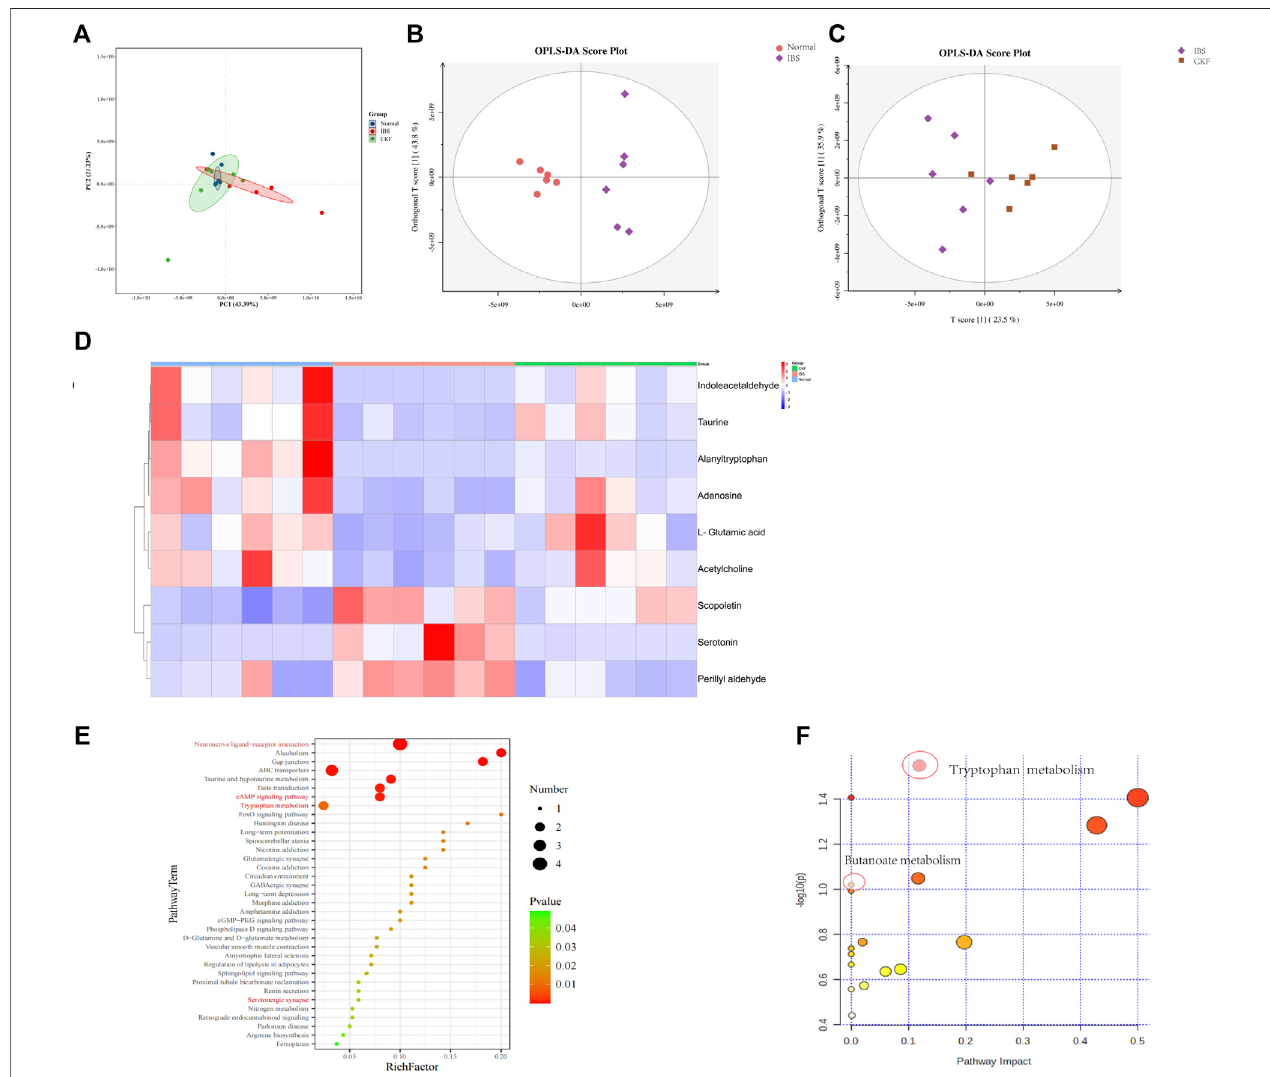
FIGURE9| PCA&OPLS-DAscoreplotsforNormal,IBS,andCKFgroups.PCA&OPLS-DAscoreplotsforserumcomparisons (A) Normal,IBS,andCKF (B) IBS vs. Normal group (C) IBS vs. CKF group. (D) Heatmap to visualize the intensities of differential metabolites in the serum samples ( n = 6). (E) KEGG pathway analysis of differentially expressed metabolites ( p < 0.05). (F) Summary of pathway analyses along with metabolomics MetPA.